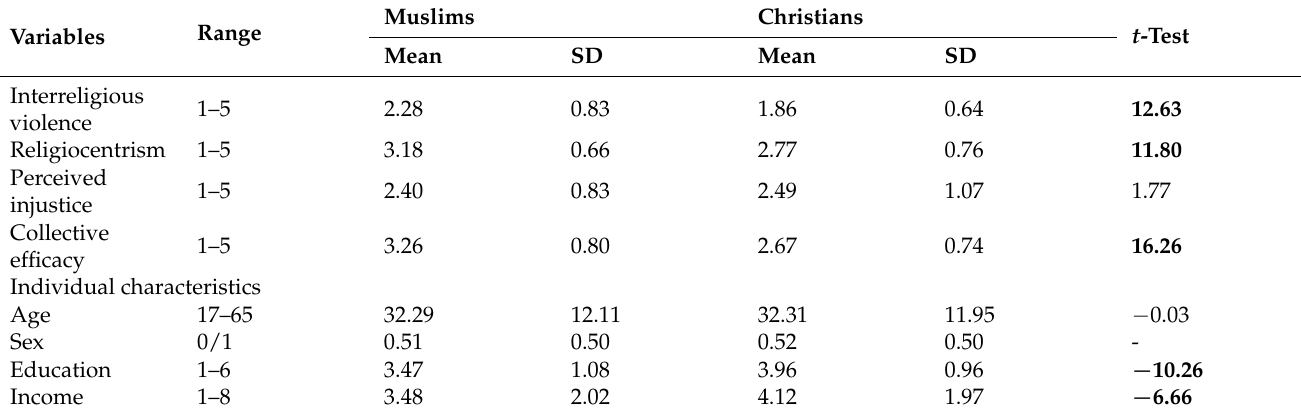
Table 1. Descriptive statistics and mean differences.